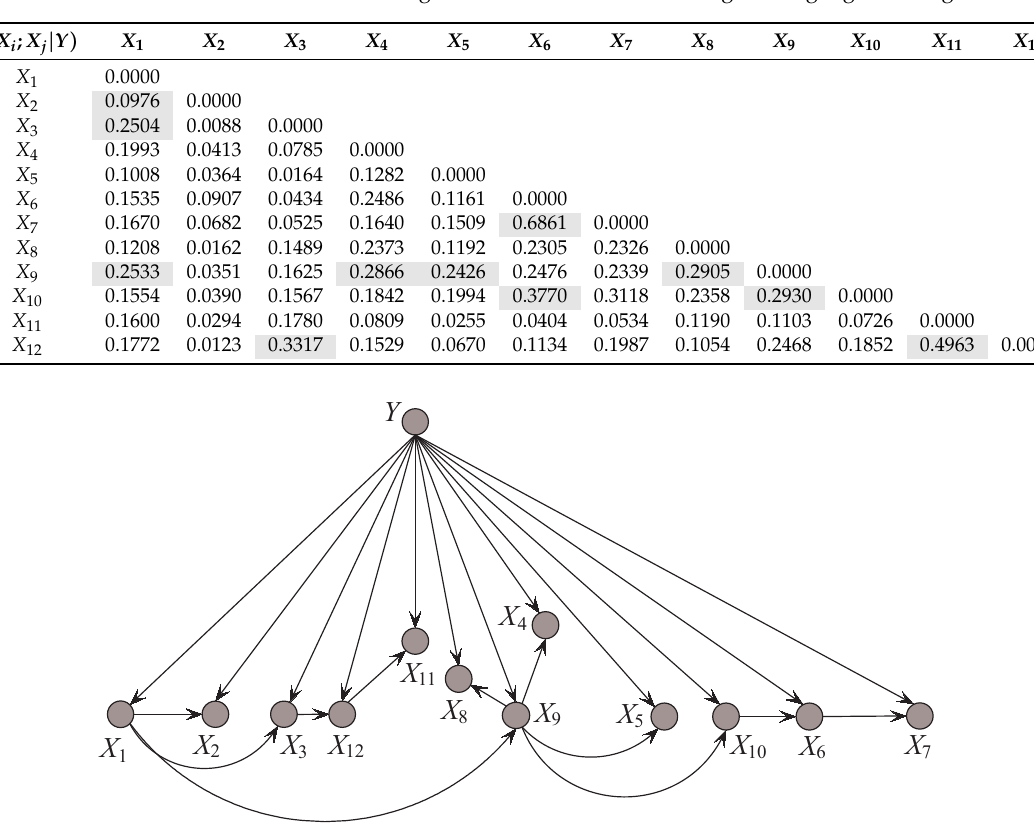
Table 2. The CMI matrix of deciding factors to attitude toward English language learning.